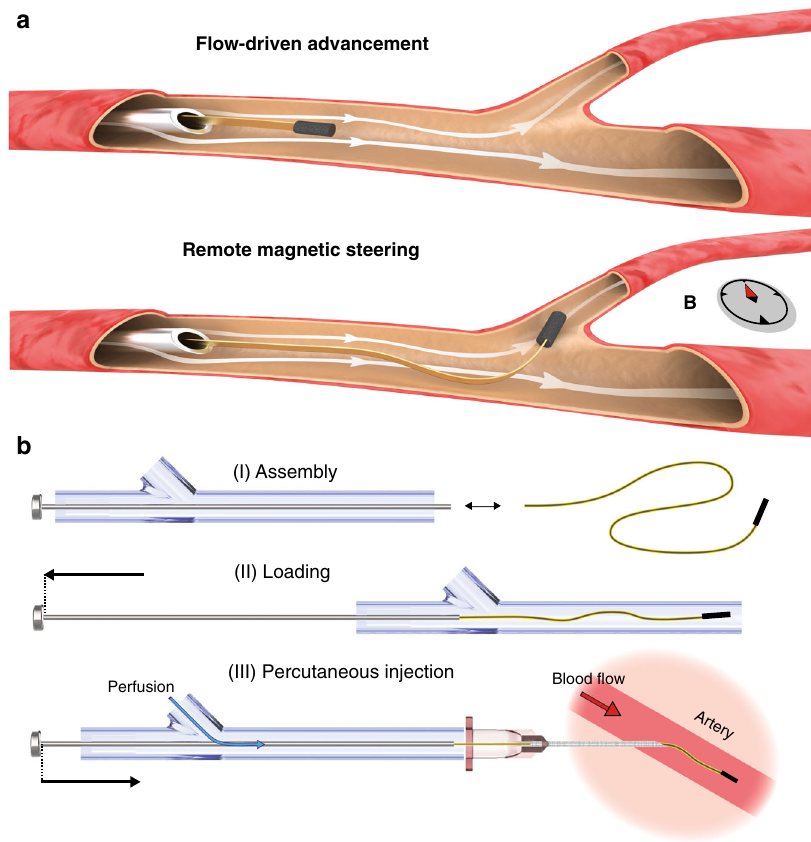
Fig. 1 Flow-driven deployment and advancement of endovascular µ -probes. a Ultra- fl exible µ -probes are transported inside vessels by the hydrodynamic forces (top). Controlled rotation of the magnetic head using external magnetic fi elds steers the device into the target vessel (bottom). The small size of the μ -probe allows direct release into the vessels with standard hypodermic needles. b Effective deployment of the μ -probes using a proper cannulation system that overcomes mechanical instabilities. Perfusion with a physiological solution during delivery keeps the structure under tension until the fl ow in the artery takes over. Drawings are not to